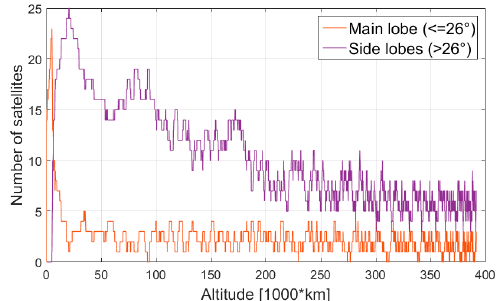
Figure 2. Number of GPS satellites received from main and side lobes of the transmitters’ antenna pattern, for the assumed MTO in Section 2.1.